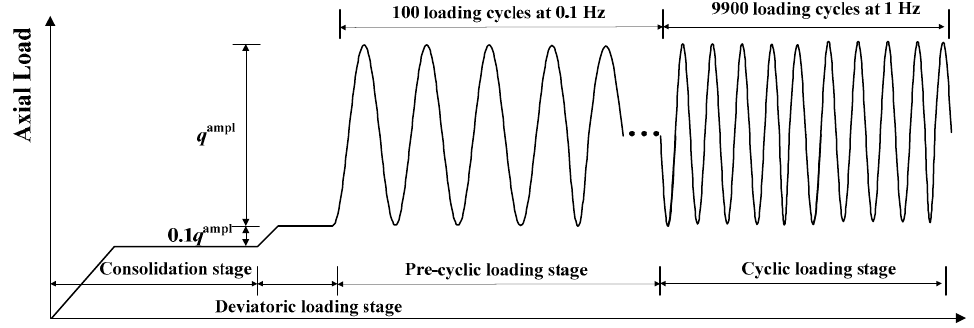
Figure 4. Cyclic loading program.